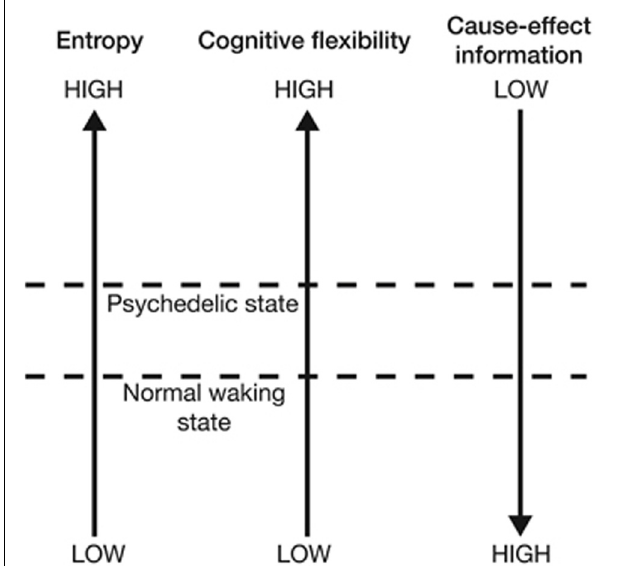
FIGURE 4 | “Increasing neural entropy elevates cognitive flexibility at the expense of a decrease in the cause-effect information specified by individual mechanisms” (Gallimore, 2015, p.